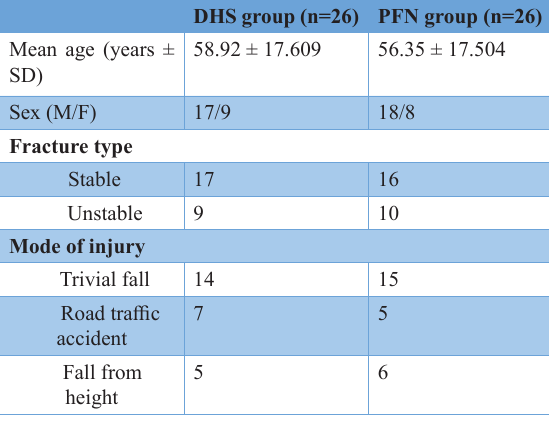
Table 1. Patients demography between DHS and PFN group.